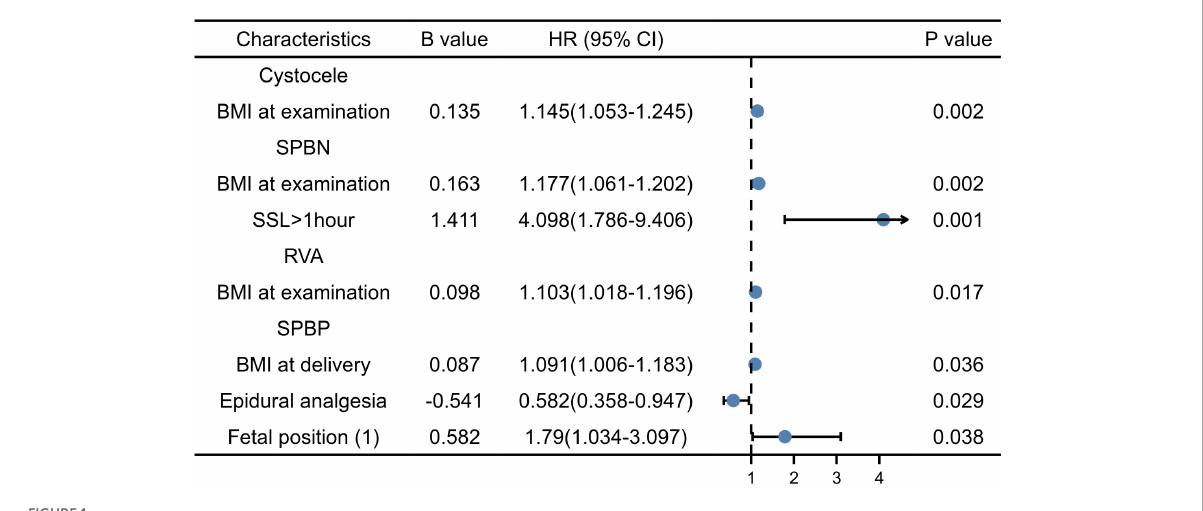
different fetal positions also had an impact on SPBN ( Table 1